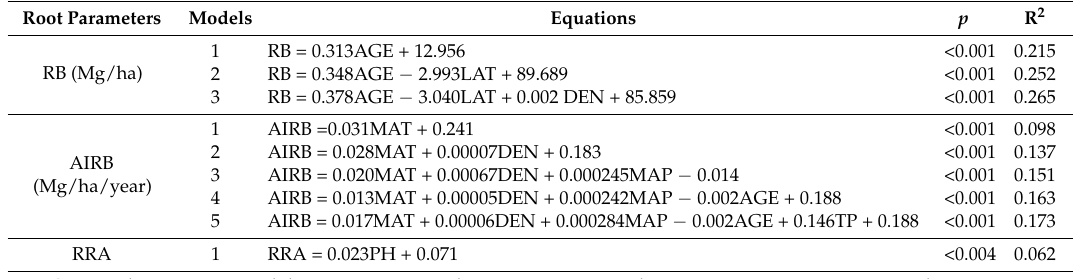
Table 2. Stepwise multiple regressions (SMR) between forest root biomass per ha (RB, Mg/ha), annual increment of root biomass per ha (AIRB, Mg/ha/year), ratio of root biomass per ha and aboveground biomass per ha (RRA) with stand characteristics and environmental factors in southwest China.